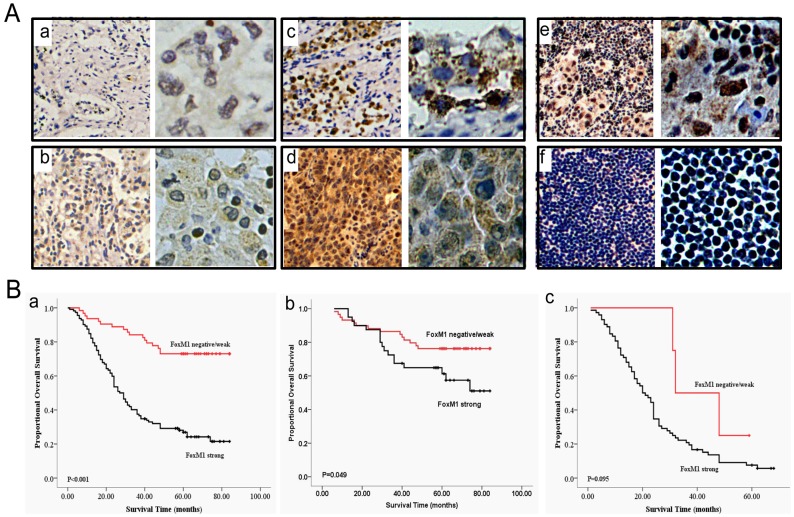
FoxM1 overexpression correlated with substantially poor prognosis of NSCLC patients.(A) Representative results of FoxM1 staining in NSCLC tumor tissues analyzed by immunohistochemistry (a, negative; b, weak; c, moderate; d, intense, respectively). Representative results of FoxM1 expression levels between lymph node positive (e) and lymph node negative (f) (a-f, left, magnification: ×100; right, magnification: ×400). (B) Overall survival analyses for all patients (a), patients with stage I/II (b) and patients with stage III/IV (c) according to the results of immunohistochemistry analysis. The log-rank test was used to test the two survival distributions. P<0.05 was considered to have statistical significance.